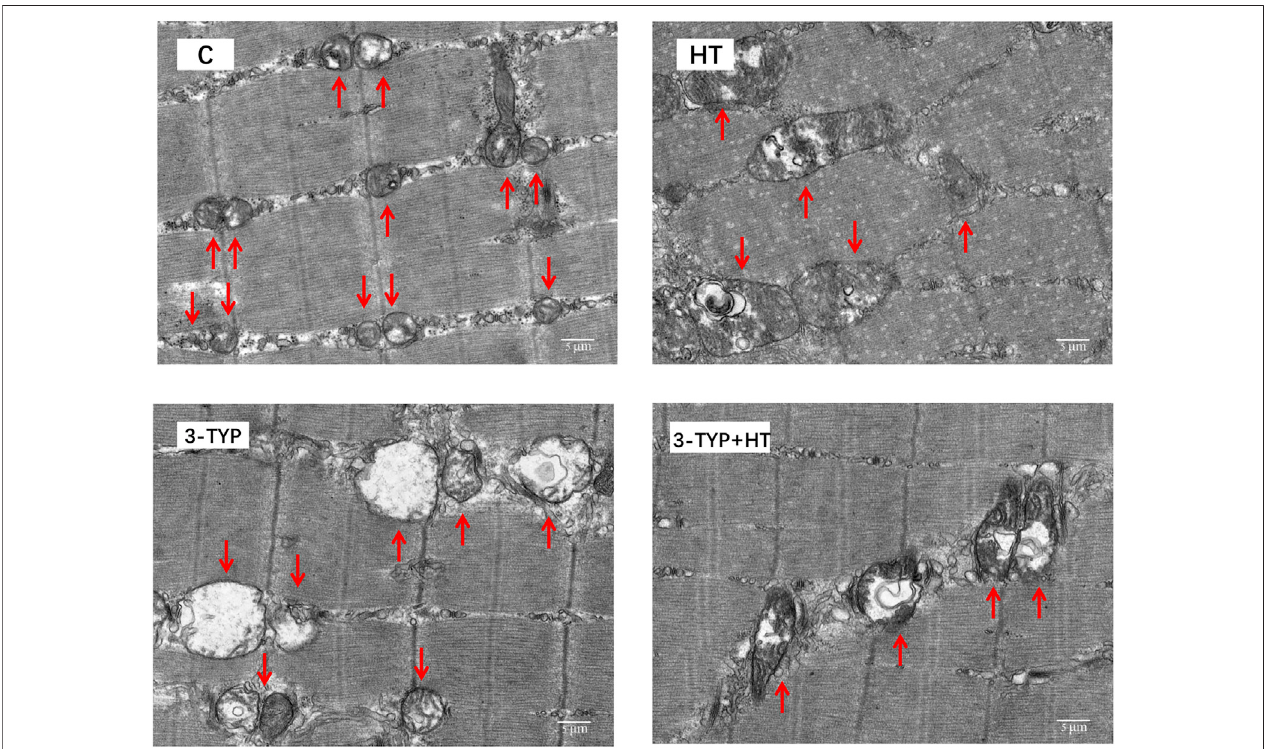
FIGURE6| Theresultsoftheultrastructureofskeletalmusclemitochondriaindifferentgroups.(×6,000).Scalebarsindicate5 μ m.C,control;HT,hypoxictraining; 3-TYP, Sirt3 inhibitor 3-TYP; 3-TYP + HT, 3-TYP + hypoxic training.